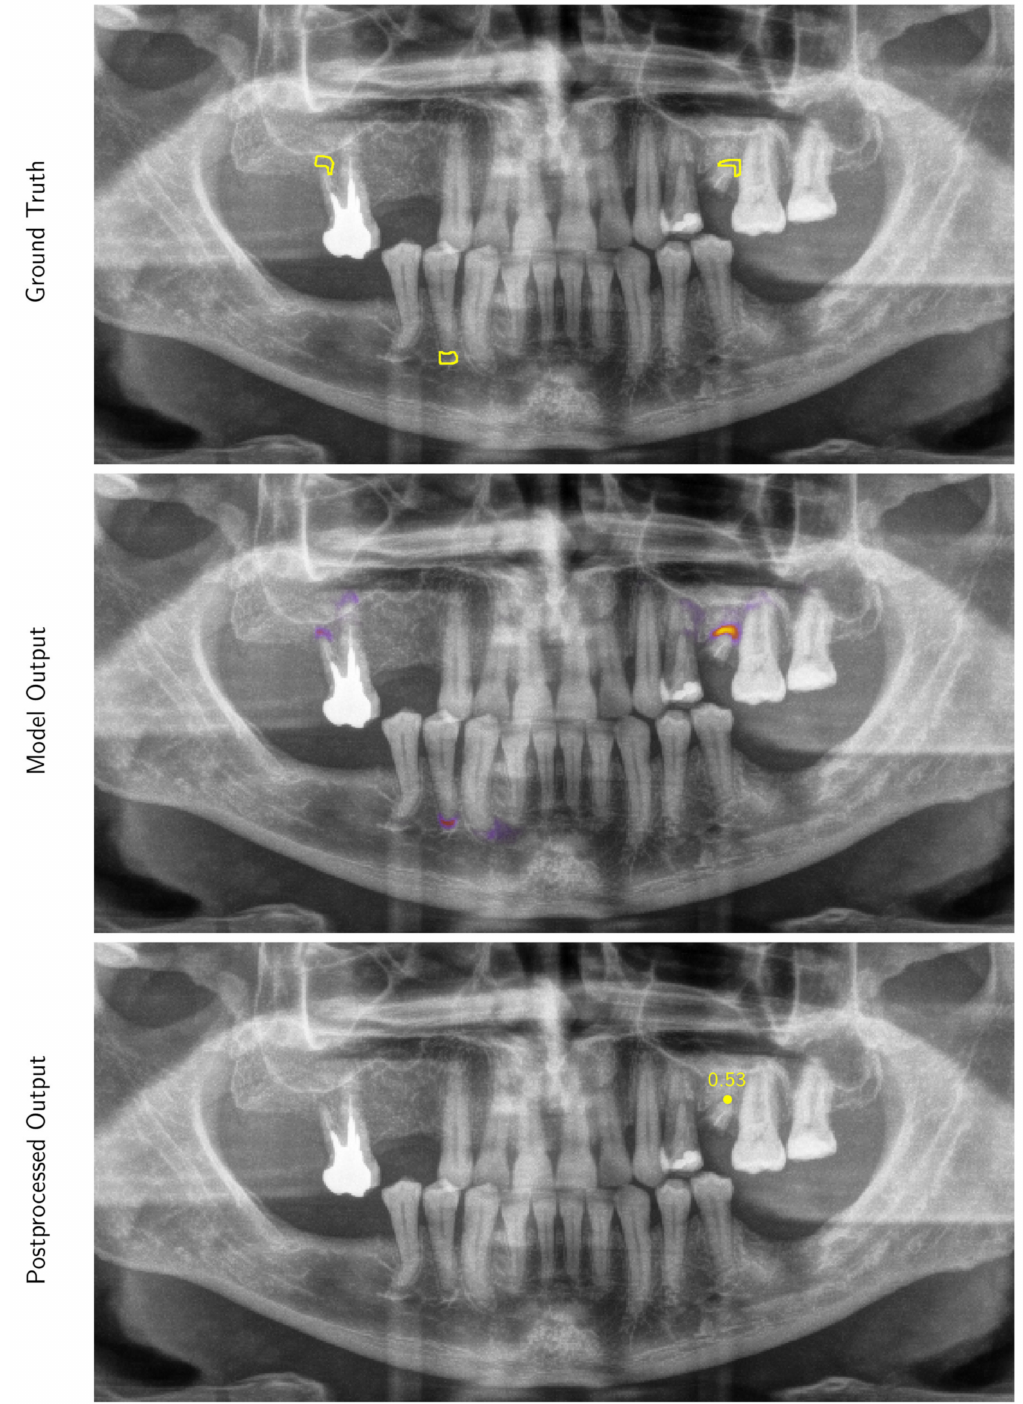
Figure A2. Example 2; see Figure A1 for